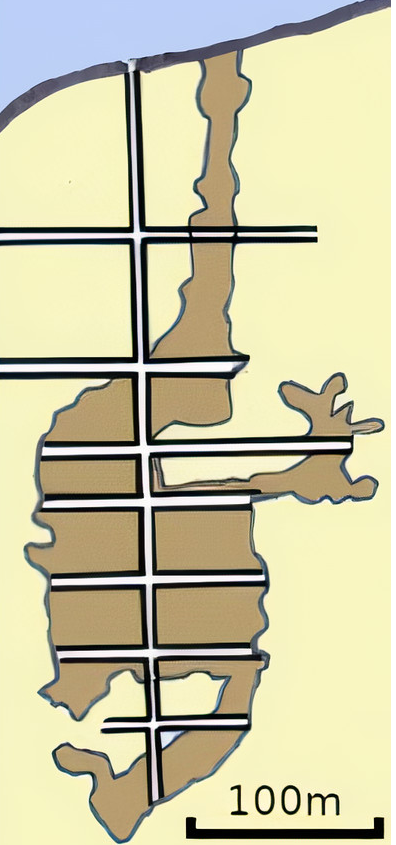
Figure 5. Simplified cross section of the Ecton mine in the